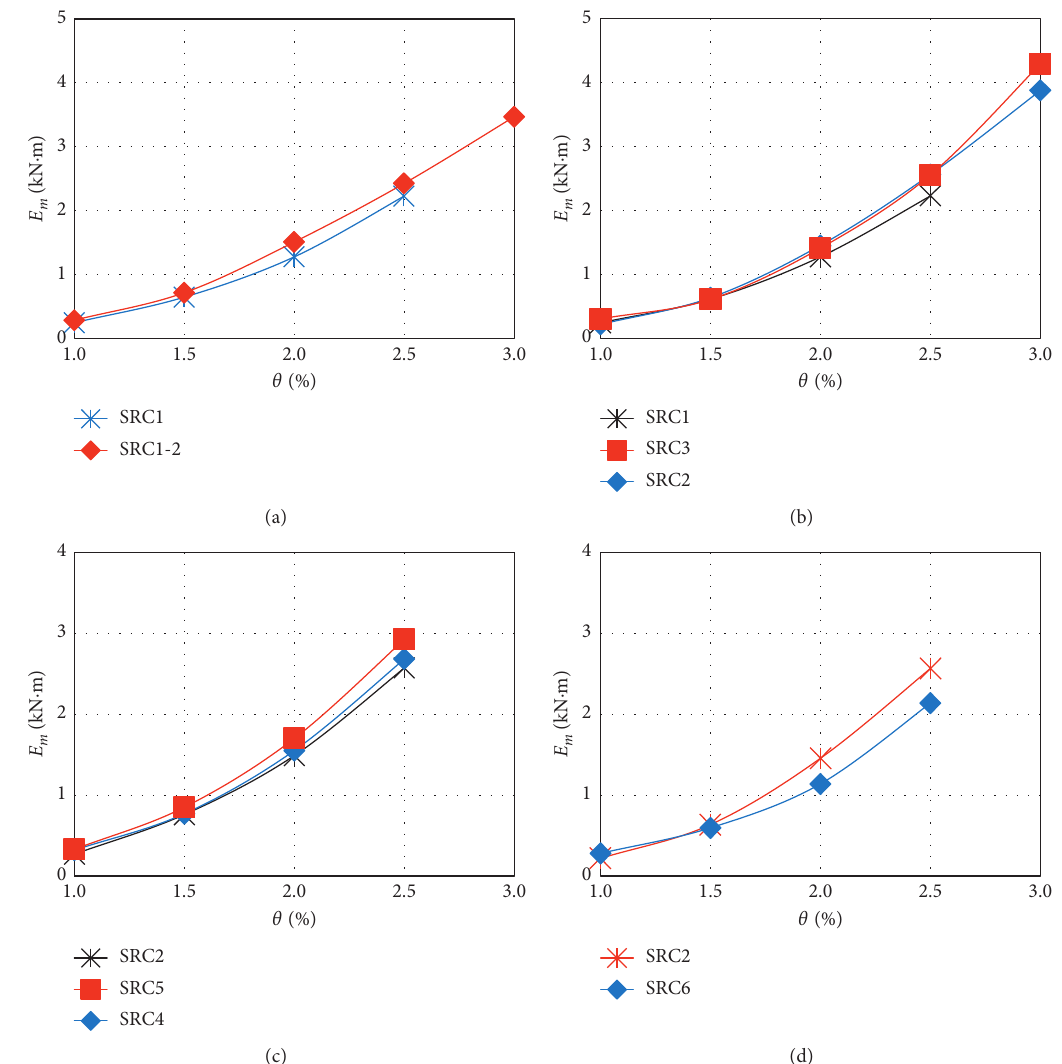
Figure 7: Relation curves of average hysteresis energy-displacement angle ( E (b) steel ratio on E m , (c) stirrup ratio on E m , and (d) axial compression ratio on E m